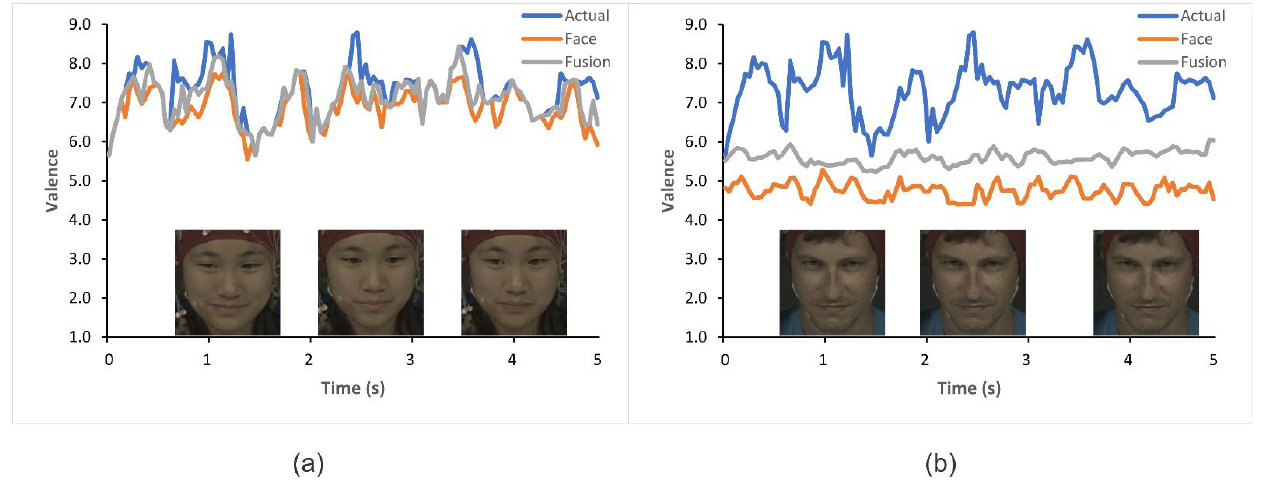
Figure 6. The examples of the valence detection against time are represented for experiment number 10 using the MAHNOB-HCI dataset. ( a ) For participant number 26, the happy state was detected correctly. ( b ) For participant number 1, it was hard to detect any particular changes on the face, but the fusion model detected a happy state successfully.